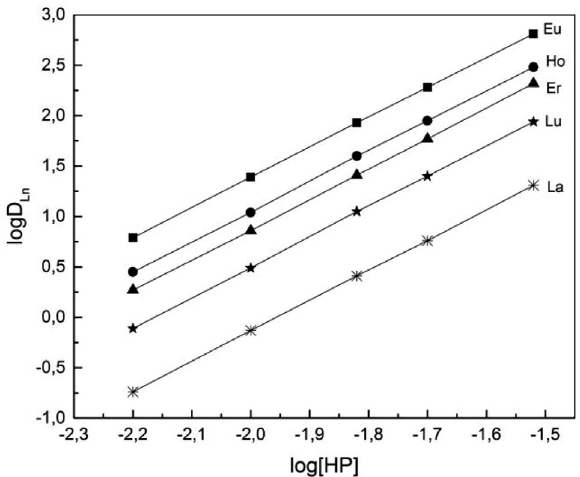
Figure 4. The effect of HP concentration in toluene containing 0.001 M compound III on the extraction of lanthanides(III) at pH = 2.0.